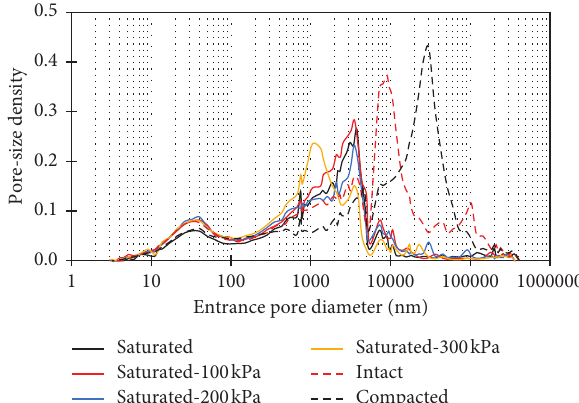
Figure 8: PSDs of saturated loess specimens consolidated to various confining stresses.